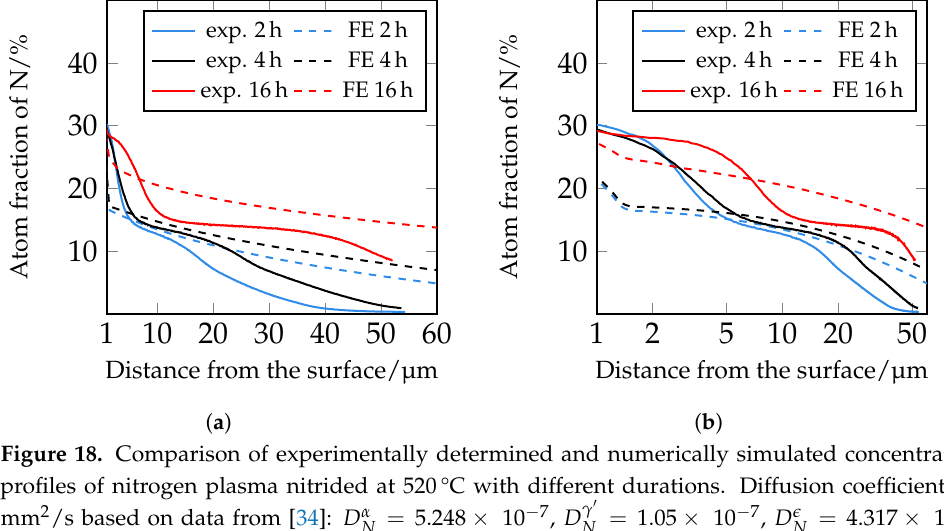
= 5.248 = 1.05 = 4.317 10 − 7 , D γ (cid:48) 10 − 7 , D (cid:101) 10 − 9 . N N N × × ×